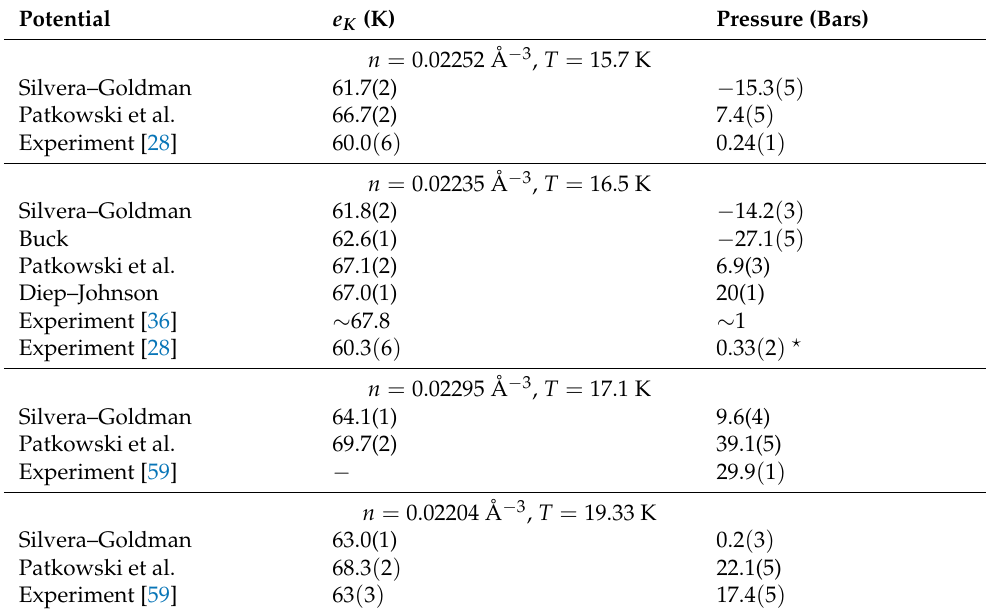
Table 1. Simulation results for the kinetic energy ( e K , in K), and for the pressure (in bars), for the liquid phase of p -H 2 computed using different intermolecular pair potentials, at various conditions of density and temperature. Statistical errors (in parentheses) are on the last digit. Also shown are the most recent experimental estimates. The symbol ∼ is used if experimental uncertainties are not provided in the quoted reference. The experimental value marked with a (cid:63) is obtained by interpolating results of Table 1 in Ref.